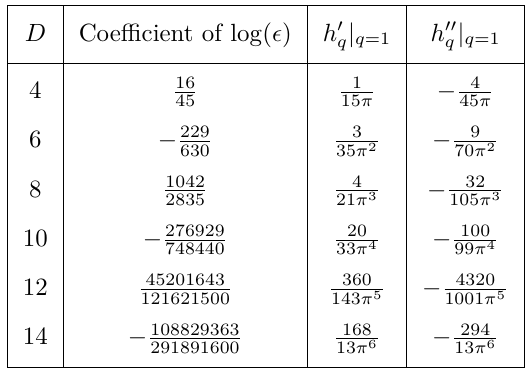
− 1 -forms. The derivatives of h q agree with 3.65 2